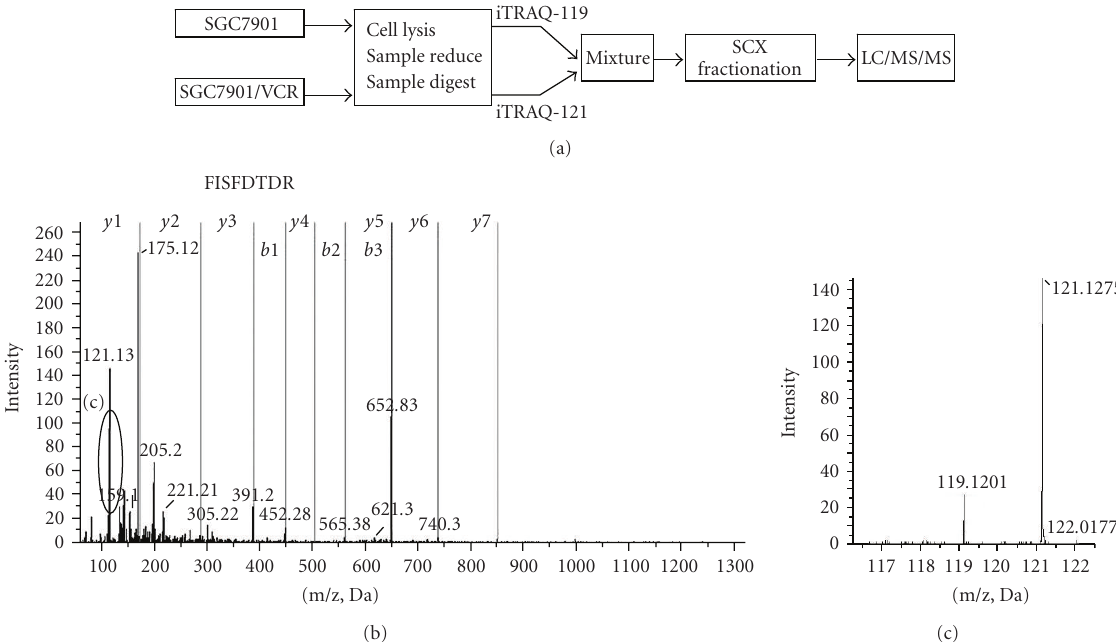
Figure 1: (a) Flow chart of iTRAQ proteomics approach. (b) A representative MS/MS spectrum showing the peptides from Sorcin (peptide sequence: FISFDTDR). The cells SGC7901/VCR and SGC7901 were labeled with iTRAQ reagents 121 and 119. So the ratio of 121 : 119 would indicate the relative abundance of Sorcin protein in vincristine-resistant SGC7901/VCR versus SGC7901 (c).